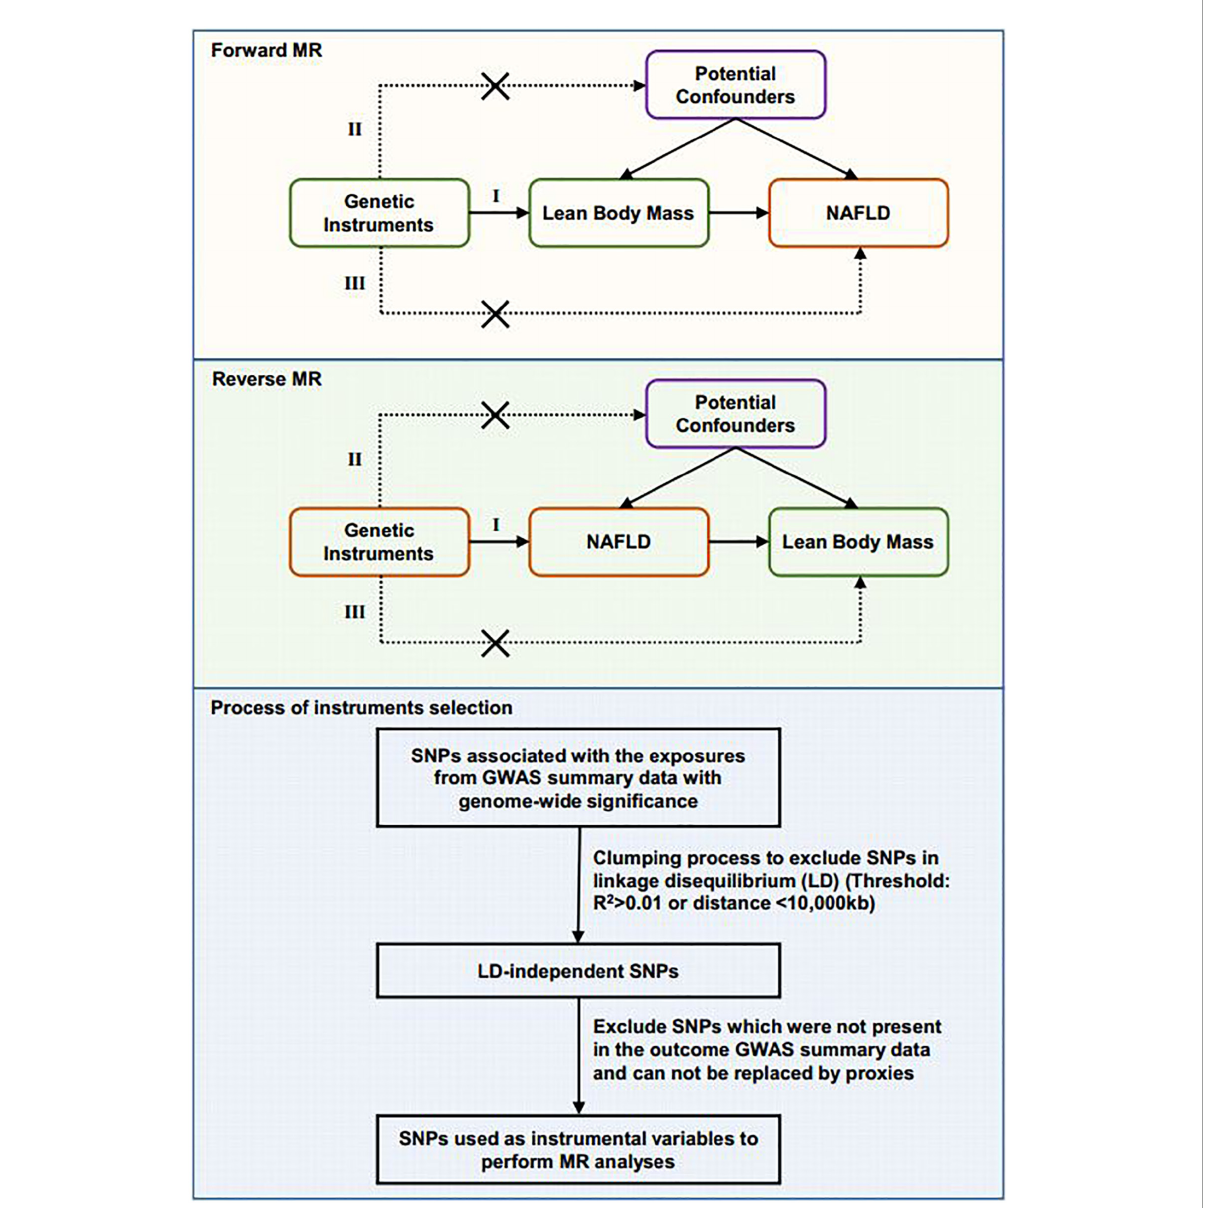
FIGURE1 Schematic diagram showing the design of the bidirectional MR analysis and the process of instrument selection. Assumption I: The selected genetic variants are associated with exposure. Assumption II: The genetic instruments are not associated with potential confounders. Assumption III: The genetic instruments are associated with outcome only through the pathway from exposure. The flow chart of genetic instruments selection is